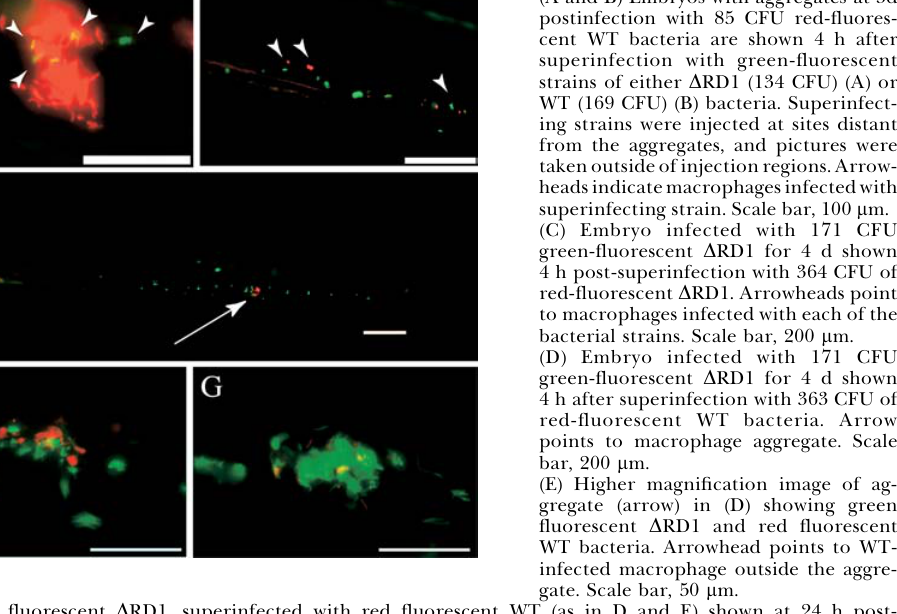
(F and G) Embryo infected with green fluorescent D RD1, superinfected with red fluorescent WT (as in D and E) shown at 24 h post- superinfection (F), and the same aggregate at 48 h post-secondary infection (G). Scale bars, 50 l m. All panels are fluorescent images. DOI: